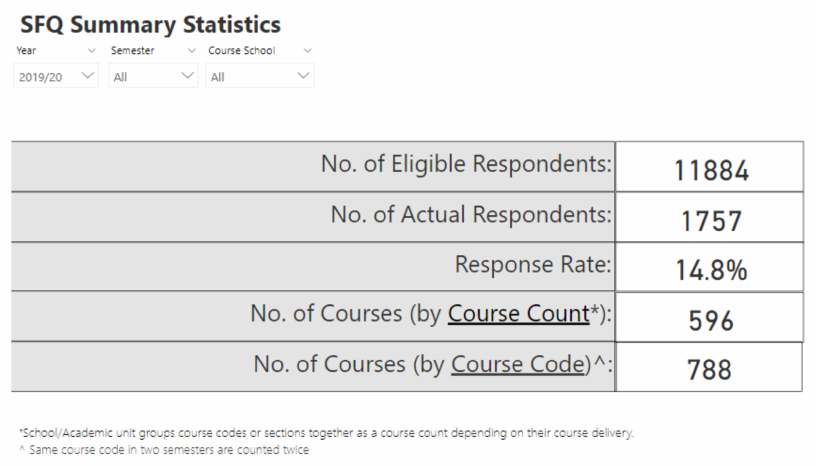
Figure 8. Course Evaluation Summary